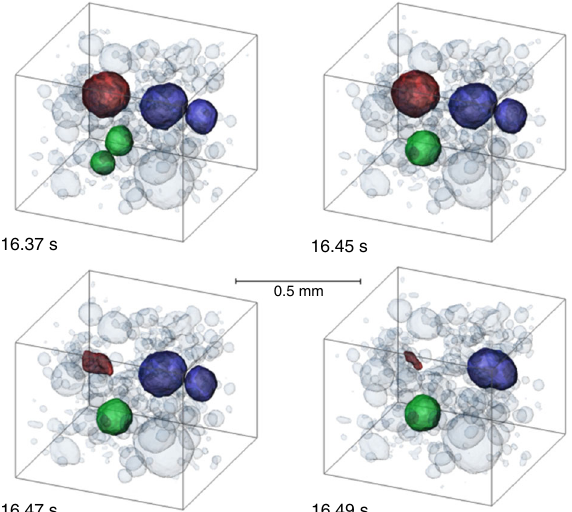
Fig. 4 Evolution of a group of fi ve bubbles in a liquid metal foam. 3D rendering of topological rearrangement of bubbles in a close neighbourhood inside a volume of 0.74 × 0.74 × 0.63 mm 3 . A cascade of events can be seen starting with the merger of two bubbles (green), collapse of another (red), and another merger of two bubbles (purple). Same alloy and tomoscopy rate as in Fig.